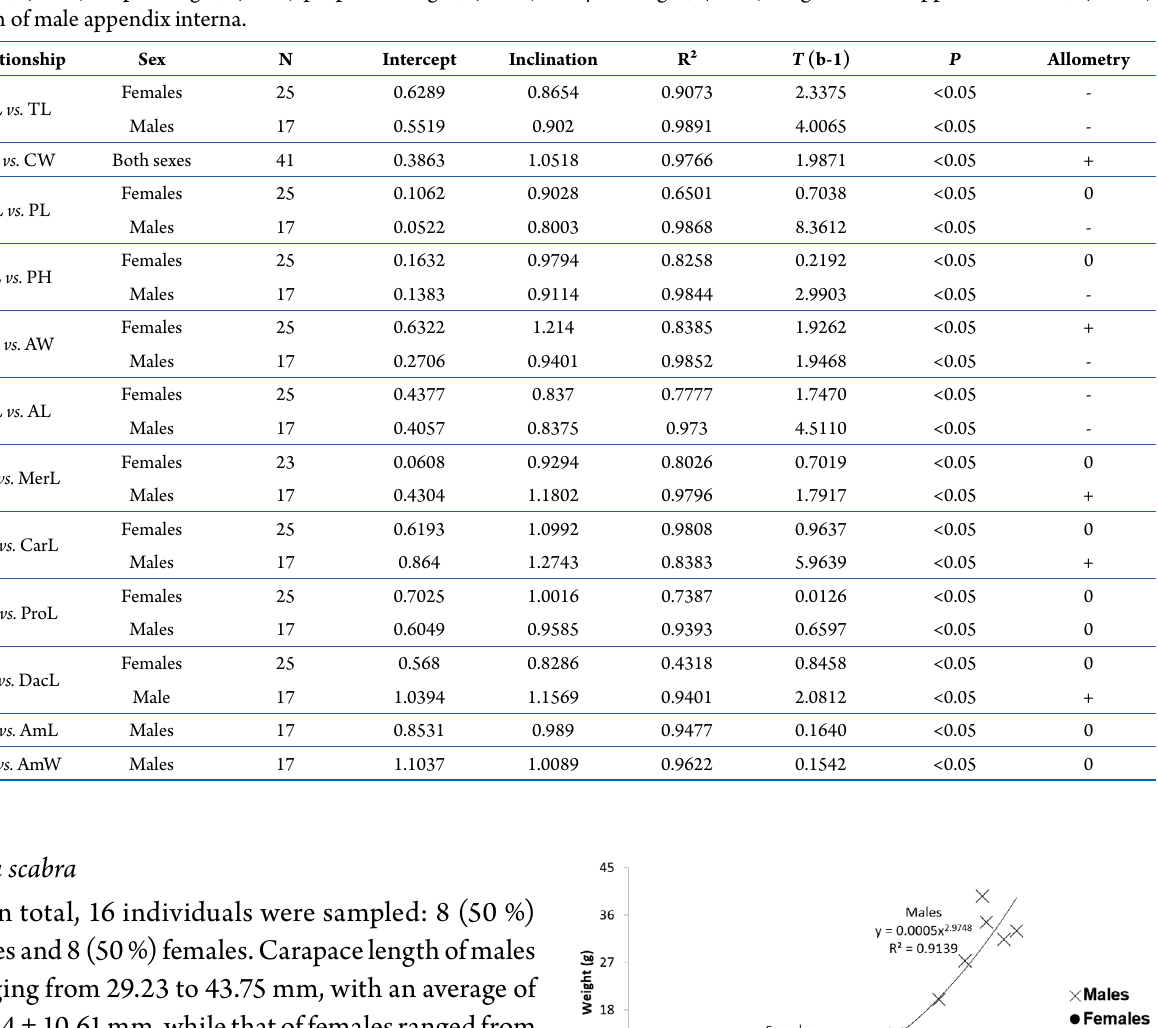
Table 2. Regression analyses of morphometric data of Atya gabonensis Giebel, 1875 at the Fluvial Island Domain in the Paraíba do Sul River basin. Carapace length (CL) is the independent variable. (PL) length of second abdominal pleuron; (PH) height of second abdominal pleuron; (CW) carapace width; (TL) total length; (AW) abdomen width; (AL) abdomen length; (MerL) merus length; (CarL) carpus length; (ProL) propodus length; (DacL) dactylus length; (AmL) length of male appendix interna; (AmW) width of male appendix interna.